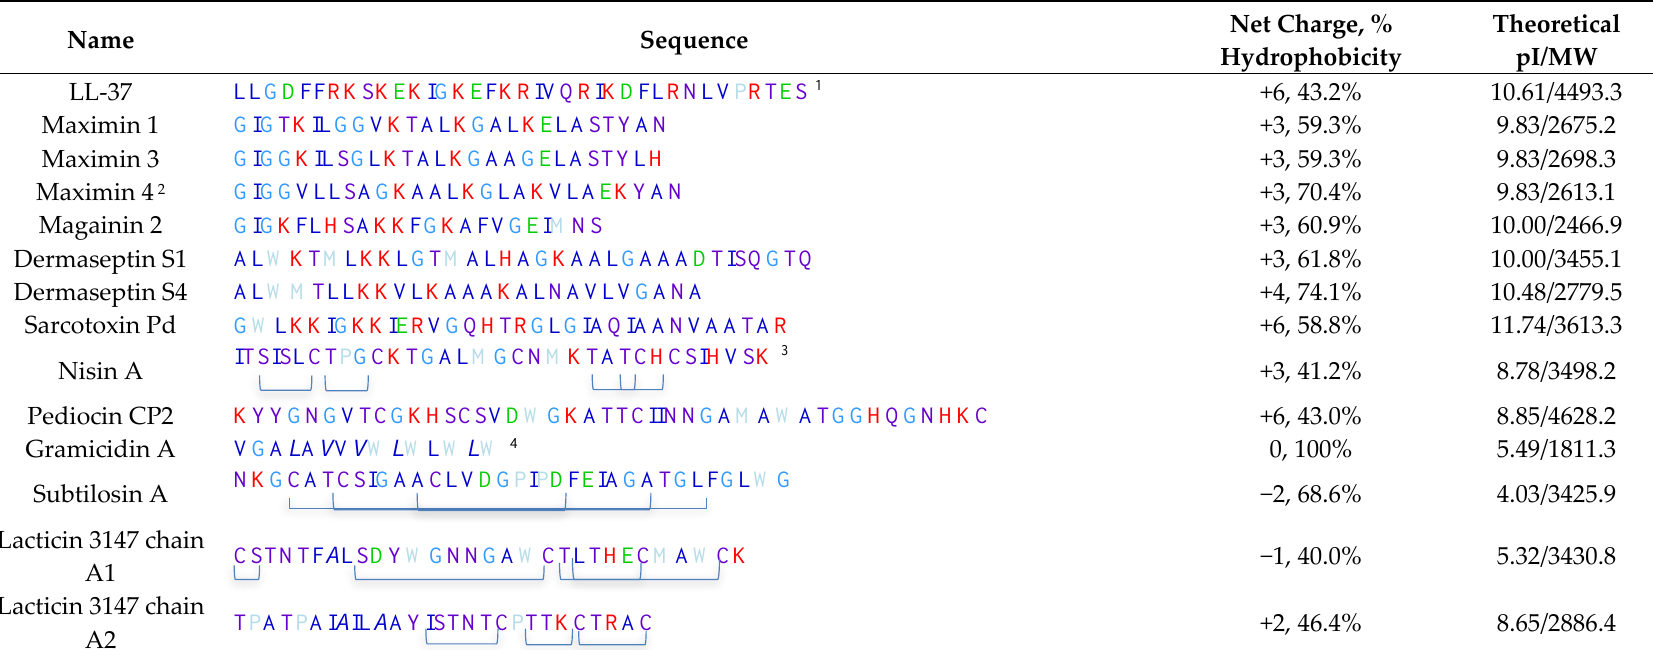
Table 3. Sequences and biochemical properites of spermicidal antimicrobial.